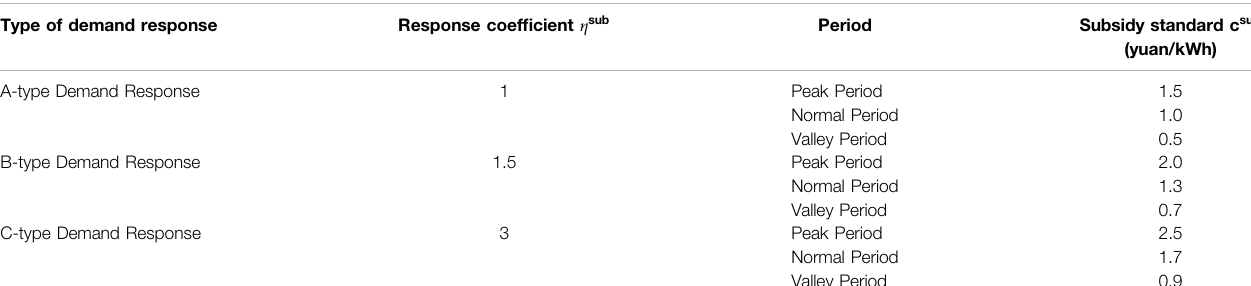
TABLE 4 | Subsidies standard of load